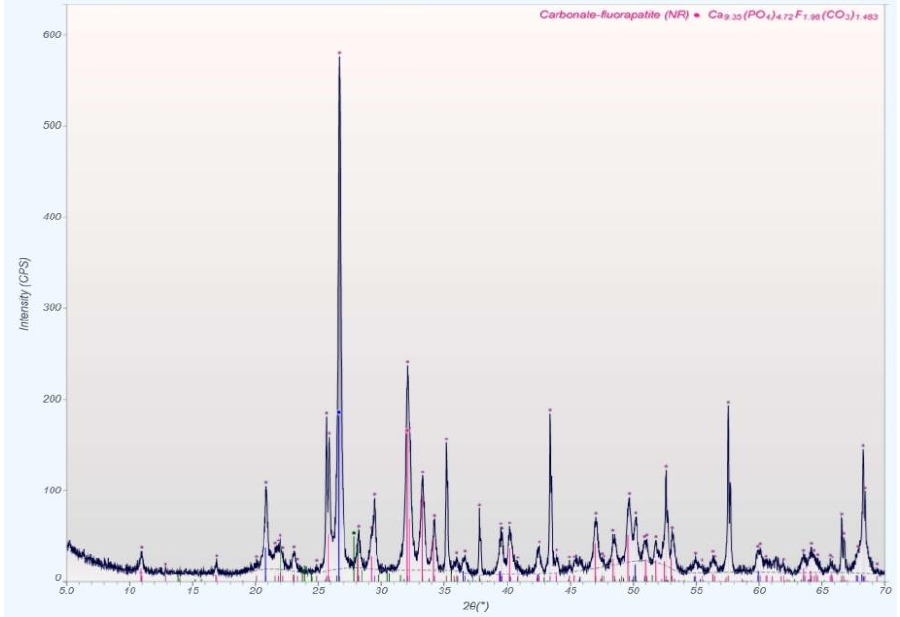
Figure D4. qXRD spectra for the organic-rich phosphorite sample HOP-5.